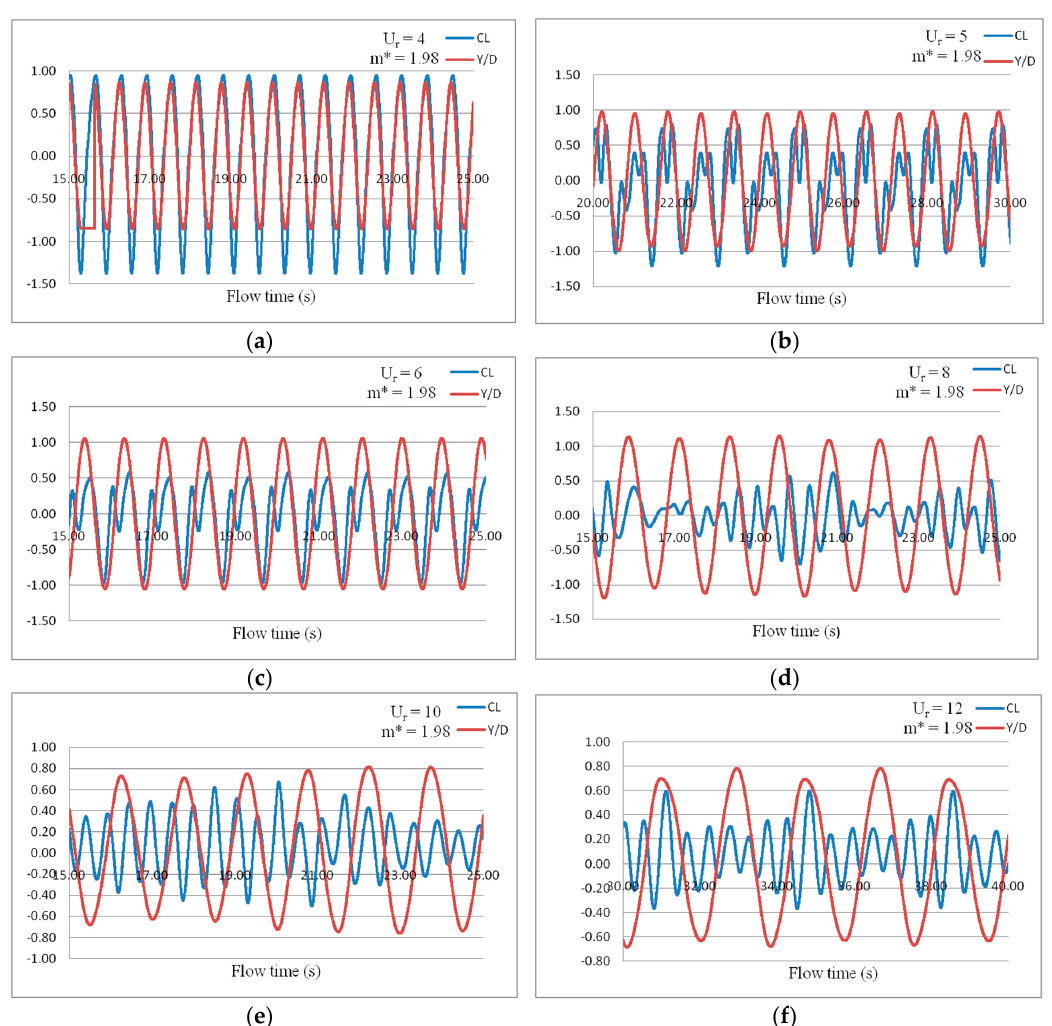
Figure 9. Variation of C L with Y/D for m* = 1.98: ( a ) U r = 4; ( b ) U r = 5; ( c ) U r = 6; ( d ) U r = 8; ( e ) U r = 10; ( f ) U r = 12.